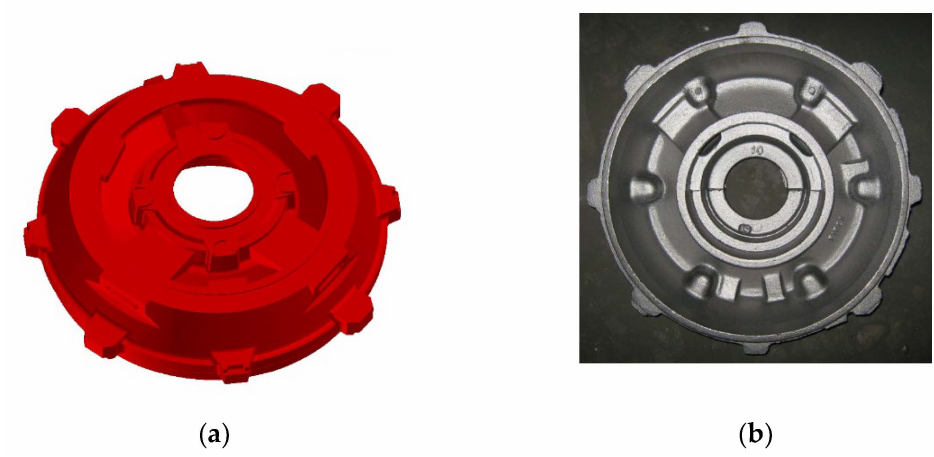
Figure 5. ( a ) Three-dimensional solid and ( b ) actual appearance of tested cast of electric motor shield.